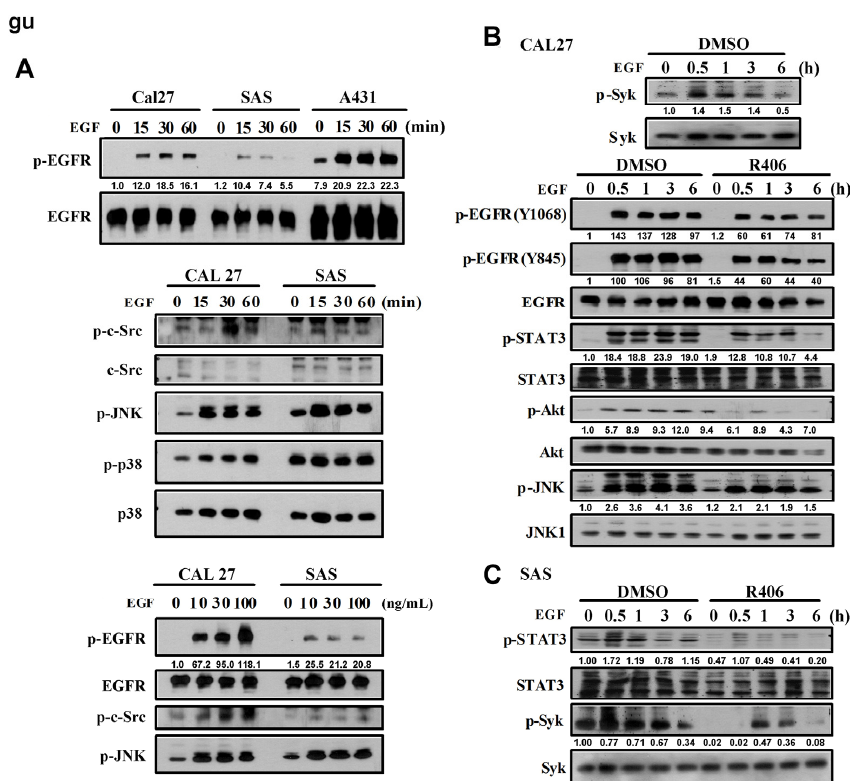
Figure 2. Syk is also an upstream signalling molecule of EGFR in SCC. ( A ) EGF-induced phosphorylation of EGFR and downstream signalling molecules for 0, 15, 30, and 60 min after EGF (100 ng/mL) treatment compared to that of A431. Concentration-dependent EGF treatment (0, 10, 30, and 100 ng/mL) for 30 min in CAL27 and SAS cells. ( B , C ) Phosphorylation of EGFR and downstream signalling molecules after EGF (100 ng/mL) treatment with or without R406 (1 μ M) for 0, 0.5, 1, 3, and 6 h in CAL27 ( B ) and SAS cells ( C ). Data are presented from three independent experiments.